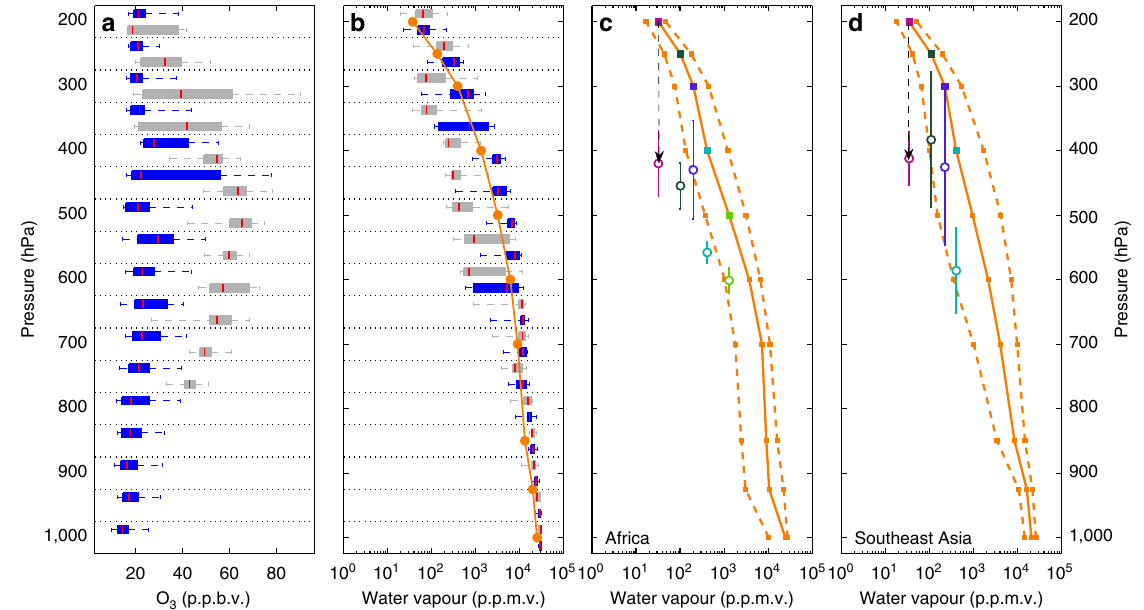
Figure 3 | Structure of ozone and water vapour in the TWP. ( a ) Profiles of in situ O 3 during CASTand CONTRAST for two modes of RH (blue, RH 4 20%; grey, RH o 20%). Box and whisker plots show 5th, 25th, 50th, 75th and 95th percentiles for 50hPa pressure bins. Each bin is delimited by a dotted line, and the two modes (grey and blue boxes) for a given pressure bin are offset for clarity. Between 400 and 700hPa, the average (minimum) number of observations per blue and grey box is 650 (414) and 330 (43), respectively. Observations between 300 and 400hPa were more limited with a minimum of 20 and a maximum of 56 observations. ( b ) Distribution of H 2 O for two modes of HCN (grey, HCN 4 150p.p.t.v.; blue, HCN o 150p.p.t.v.). Median AIRS H 2 O over the ascending branch of the Hadley Cell (orange). Between 300 and 700hPa, the average (minimum) number of observations per blue and grey box is 129 (28) and 111 (19), respectively. ( c ) Median (solid), 5th and 95th percentiles (dashed) of AIRS H 2 O over the African biomass burning region (orange). Open circles represent the mean end point of descent ± 1 s of trajectories starting over the African biomass burning region and arriving over the TWP, for various initial pressures (closed squares). d Same as c but for trajectories starting over Southeast